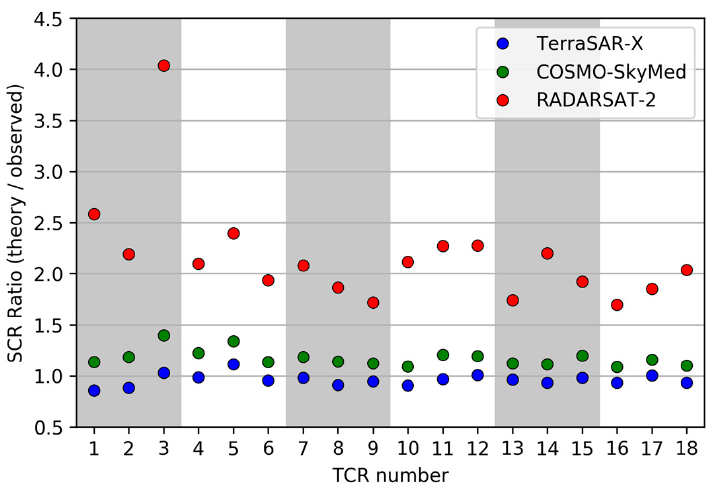
Figure 14. Ratio of theoretical SCR to observed SCR for all TCR deployed at Gunning. Background grey polygons are plotted to aid delineation of the different type groups of TCR design described in